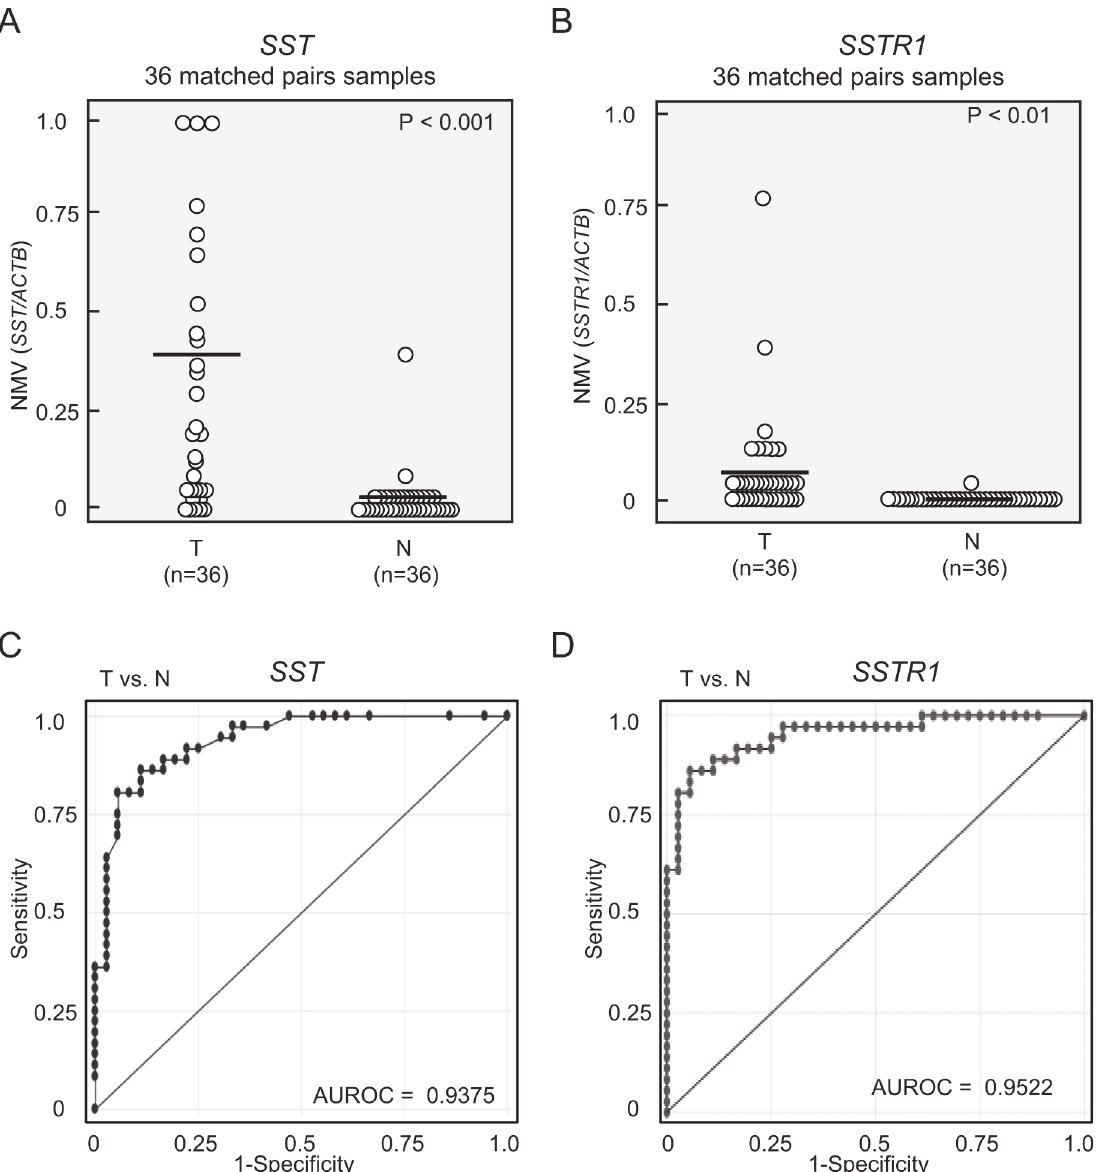
Fig 2. Hypermethylation patterns in matched pairs of head and neck tumors and adjacent normal mucosal tissues. (A) SST NMVs of head and neck tumors were significantly higher than those of paired adjacent normal mucosal tissues ( P < 0.001). (B) A higher frequency and quantity of SSTR1 methylation was noted in head and neck tumors than in matched normal mucosal tissues ( P < 0.01). (C) The area under the ROC curve (AUROC) value for the SST gene was 0.9375. At the cutoff value of 0.046, sensitivity was 80.6% and specificity was 94.4%. (D) The AUROC value for the SSTR1 gene was 0.9522. At the cutoff value of 0.012, sensitivity was 61.1% and specificity was